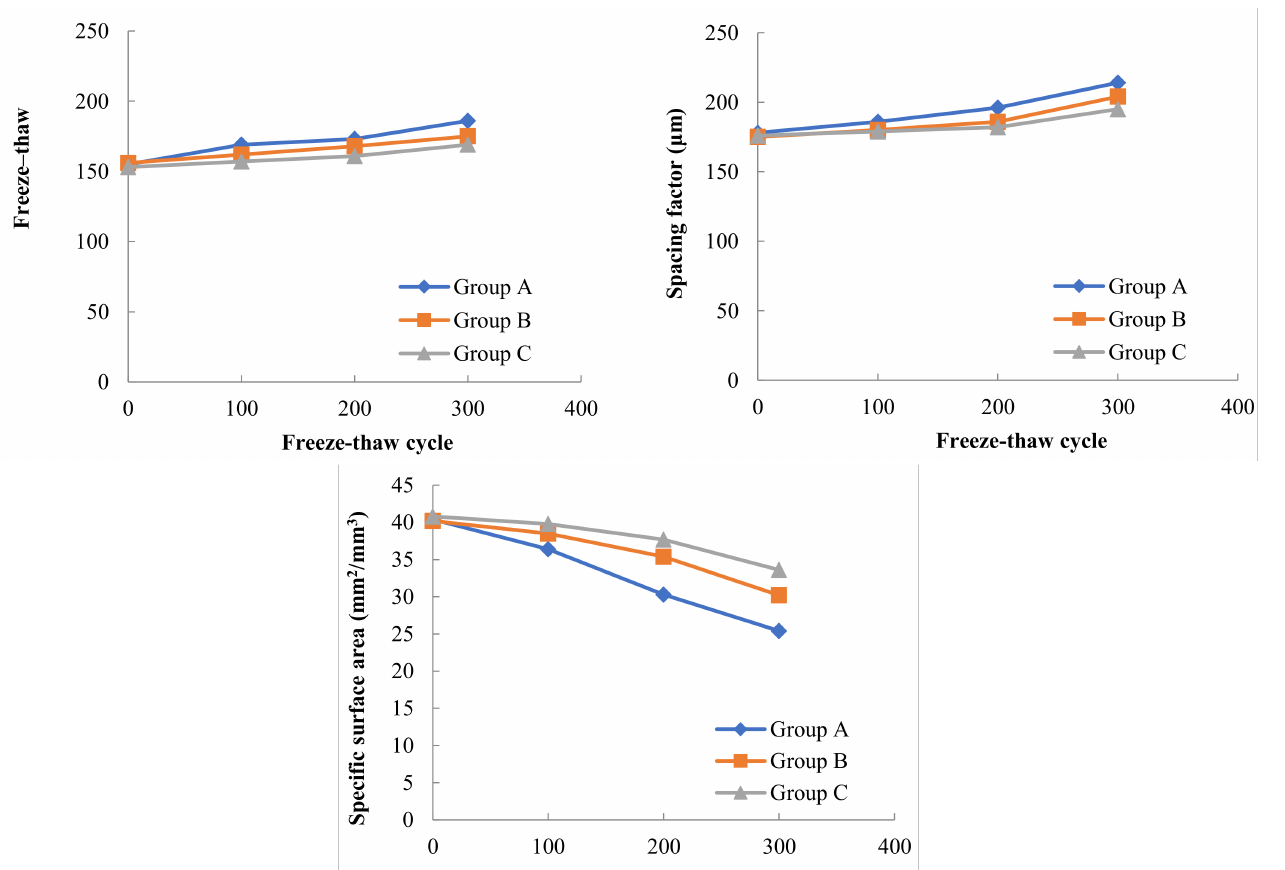
Figure 8. Variation of air void parameters for concrete with different internal water content ( − 17 ◦ C freezing